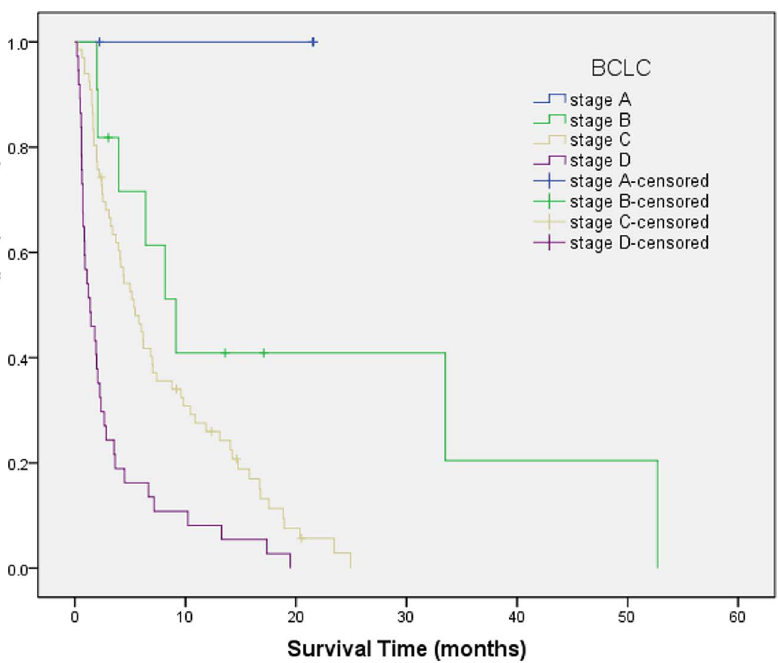
Figure 3. Survival curves for patients with unresectable hepatocellular carcinoma who were stratified according to the Barcelona Clinic Liver Cancer staging system. Stage A versus B, P=.045; stage B versus C, P=.022; stage C versus D, P=.000. All difference between groups was statistically significant.